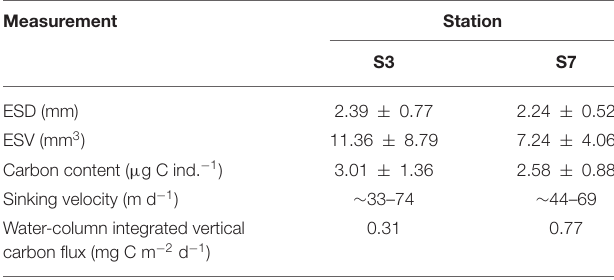
TABLE 2 | Measurements of detritus and associated carbon flux at the BL-affected station and the unaffected station in the upper 800m.